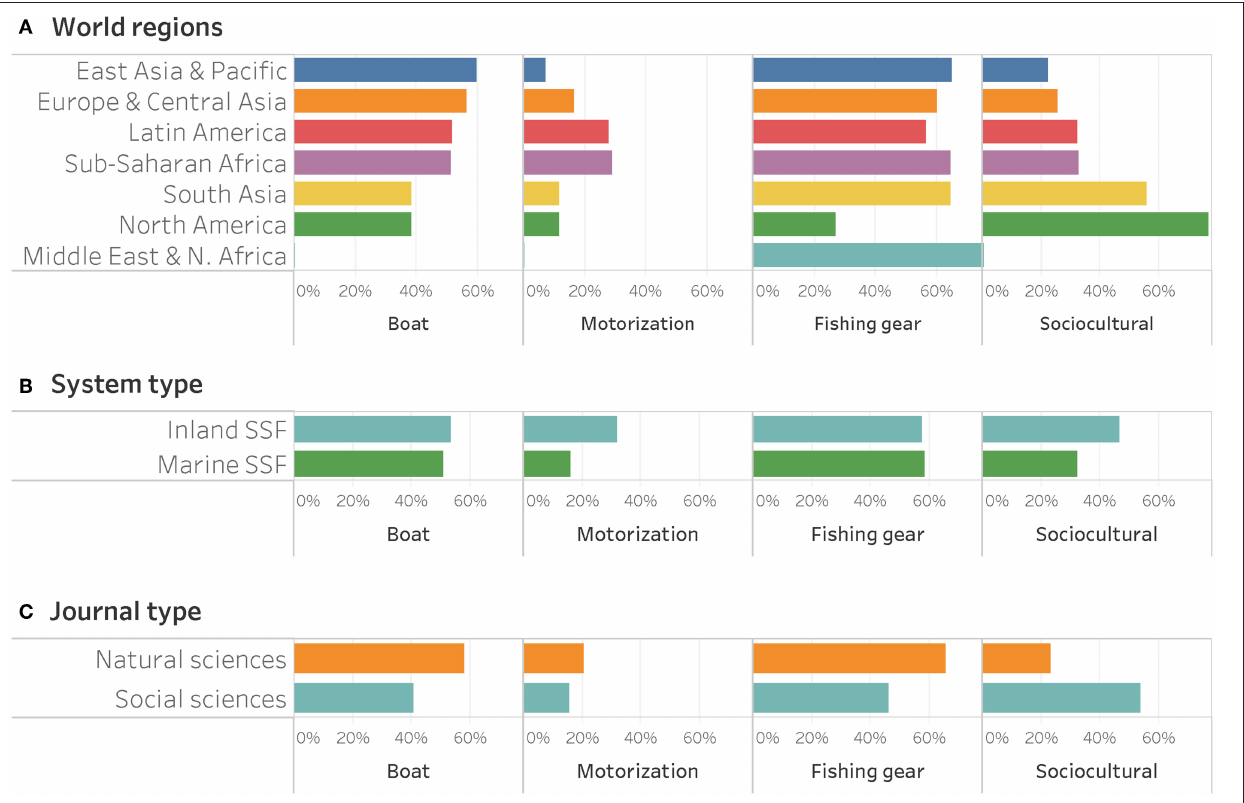
FIGURE 6 | The percentage of publications using different dimensions to define SSF by world region (A) , aquatic system type (B) , and journal outlet (C)